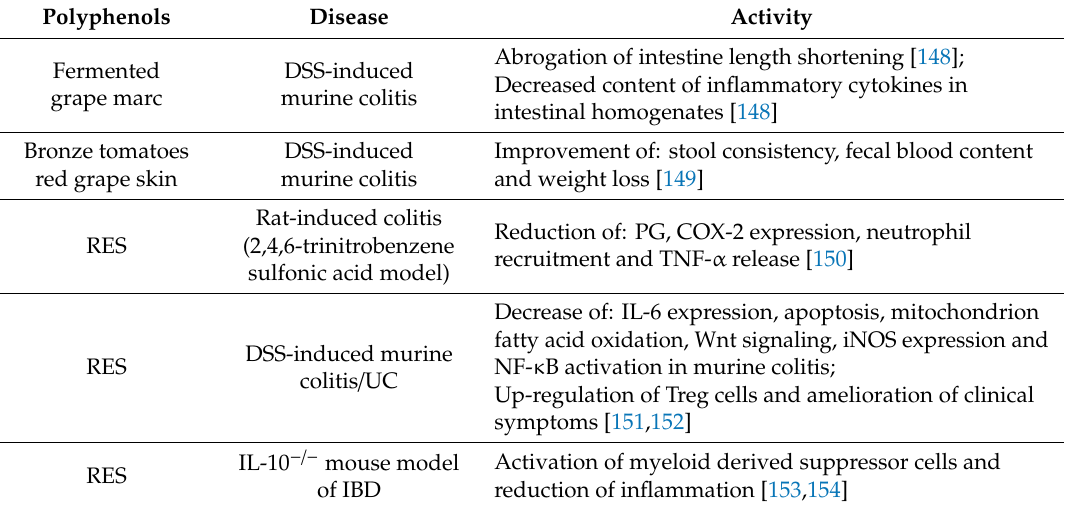
Table 4. E ff ects of red grape polyphenols on inflammatory bowel